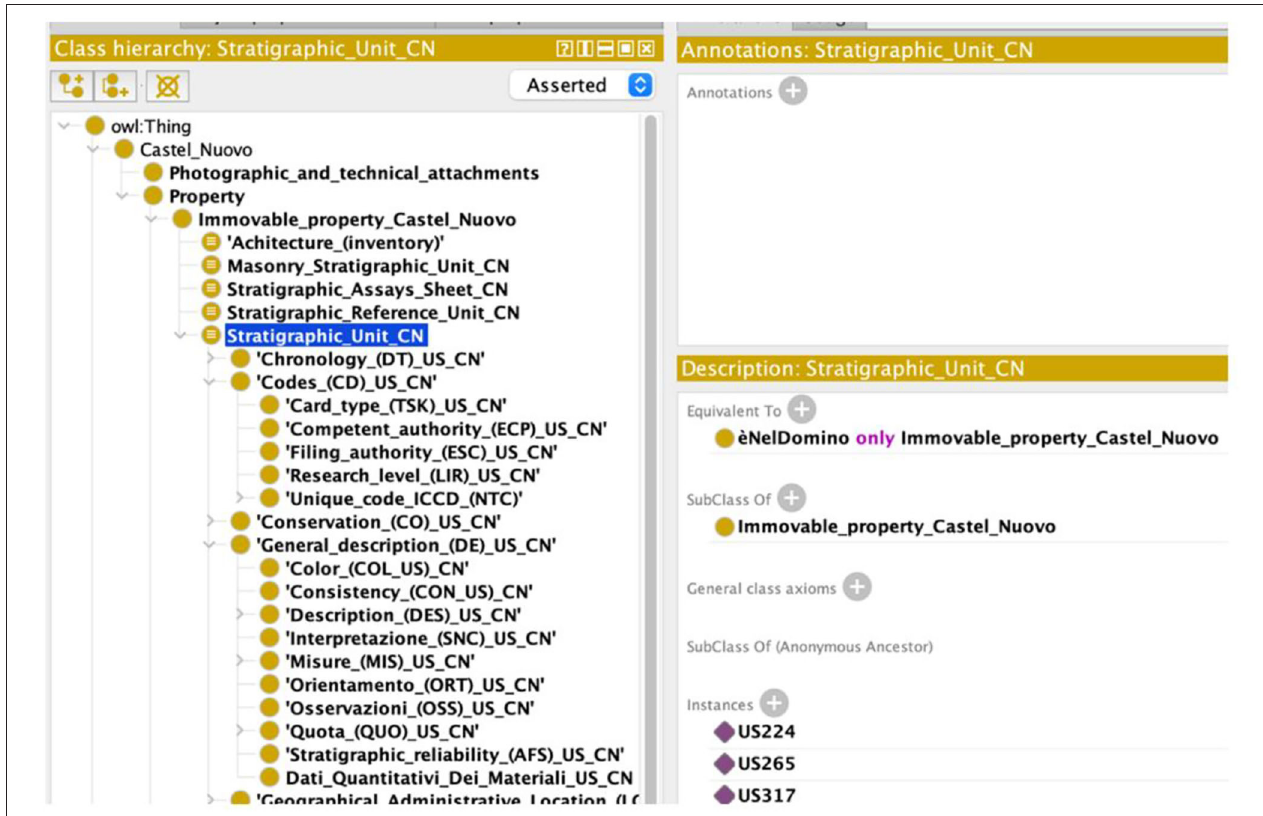
FIGURE 6 | Classes of the stratigraphic unit tab modeled in the PAUN ontology.